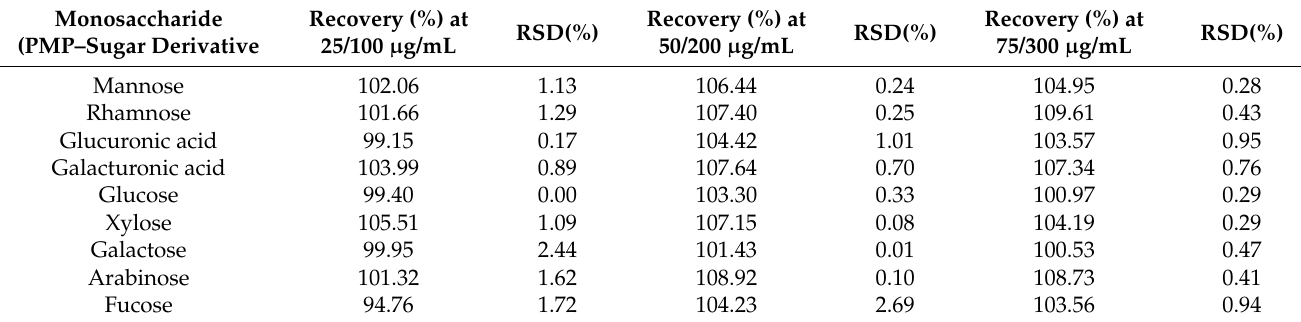
Table 3. Recovery results of the developed HPLC-DAD method for the analysis of PMP–sugar derivatives, evaluated at three spiked concentrations of sugar